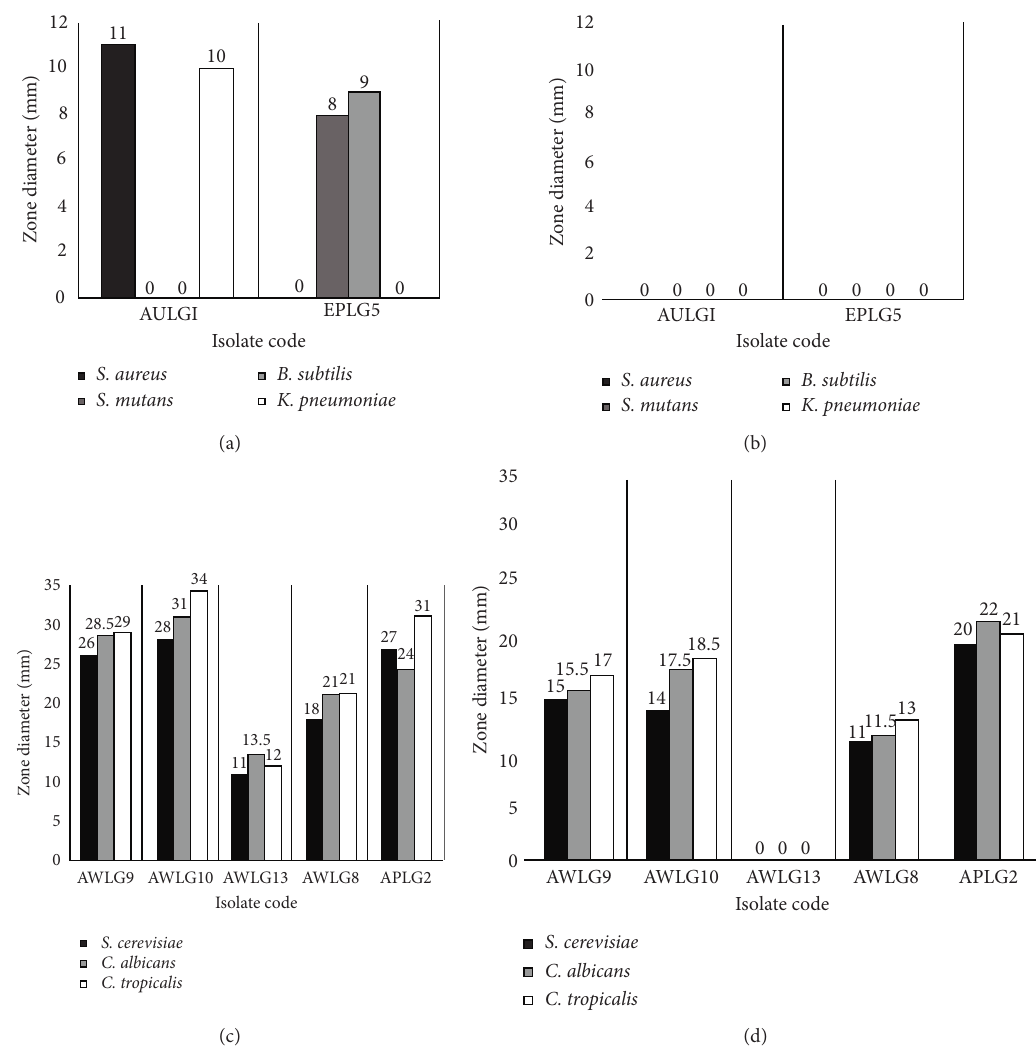
Figure 2: Antimicrobial activity of the isolates against the selected test microorganisms using agar well assay. Zone of inhibition diameter of the supernatants of the isolates against bacterial test microorganisms on the (a) 7 th and (b) 14 th day of incubation, and against yeast test microorganisms on the (c) 7 th and (d) 14 th day of incubation.